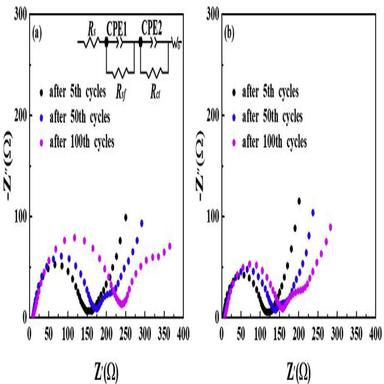
Nyquist plots of NCM622 (a) and Cu-NCM (b) samples after the 5th, 50th, and 100th cycles at 1 C between 2.8 and 4.4 V.